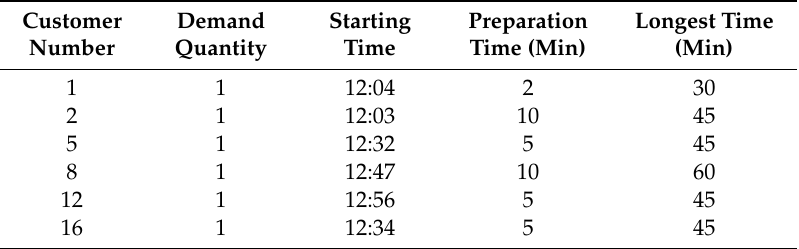
Table 1. The status of some orders of merchant